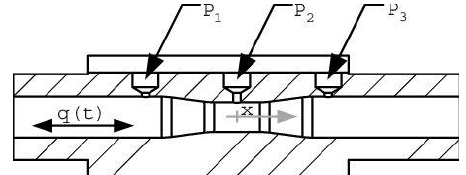
Fig. 2. Venturi tube device with pressure sensors for measurement of pulsating flow in a medical device [4].